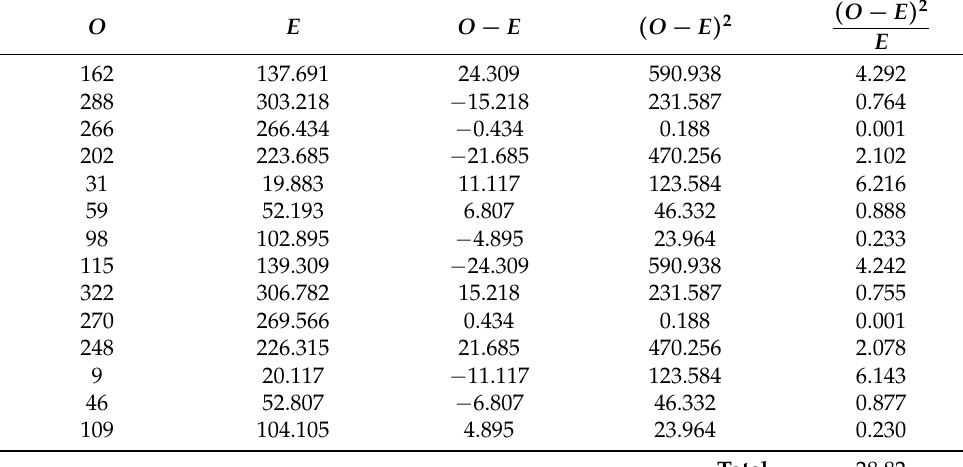
Table 4. Chi-square calculus for the question “In which social networks do you see more advertising from Apple and Samsung?”. O: Observed. E: